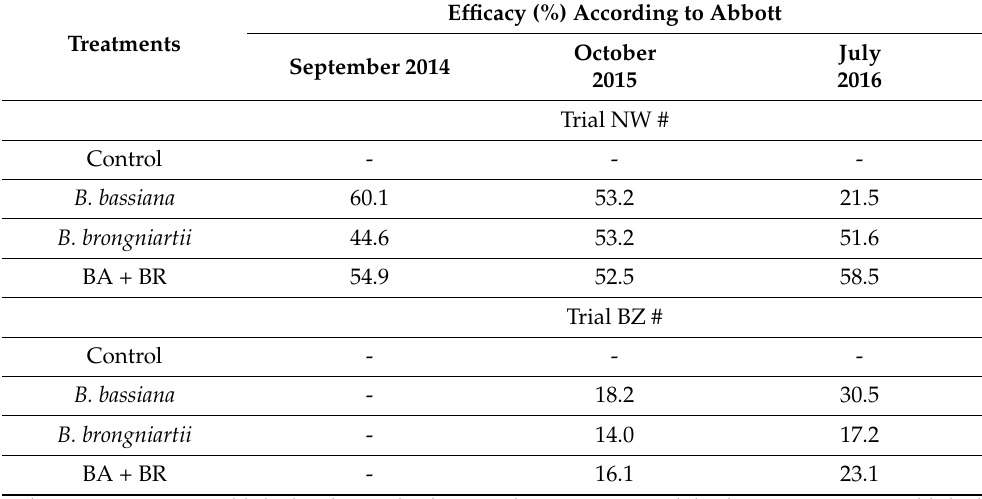
Table 1. Efficacy of formulated products containing the entomopathogenic fungi ( Beauveria bassiana (BA) and Beauveria brongniartii (BR)) as a single inoculum or as mixture (BA + BR), on reducing the damage to strawberry plants by grubs of M. melolontha